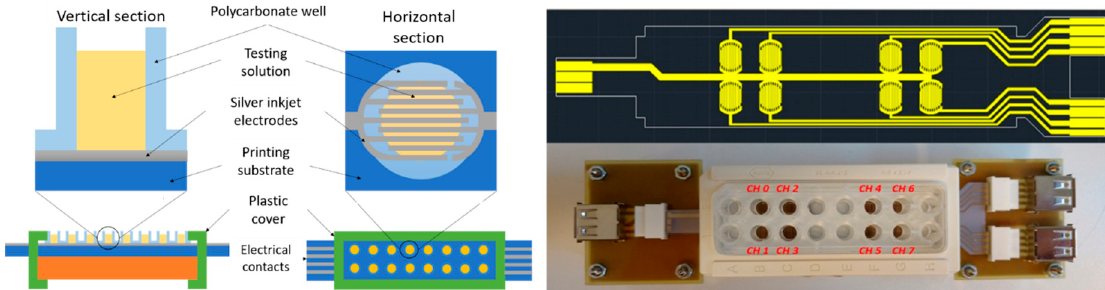
Figure 2. On the left , section and top view schemes of a single well ( top ) and of the entire ( bottom ) interdigitated electrode array (IDEA) system; on the right , layout of the inkjet-printed electrodes and a picture of the assembled IDEA system.